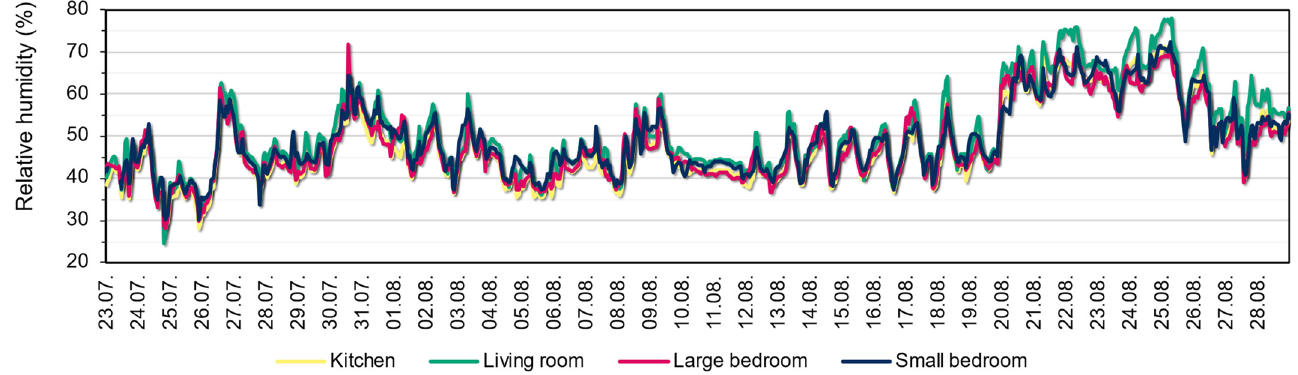
Figure 10. Measured temperature values within the apartment, including the 26 °C regulatory threshold temperature. Table 1. Statistics of the measured temperature and relative humidity (K—kitchen, LR—living room, SB—small bedroom, LB—large bedroom, E—external balcony).